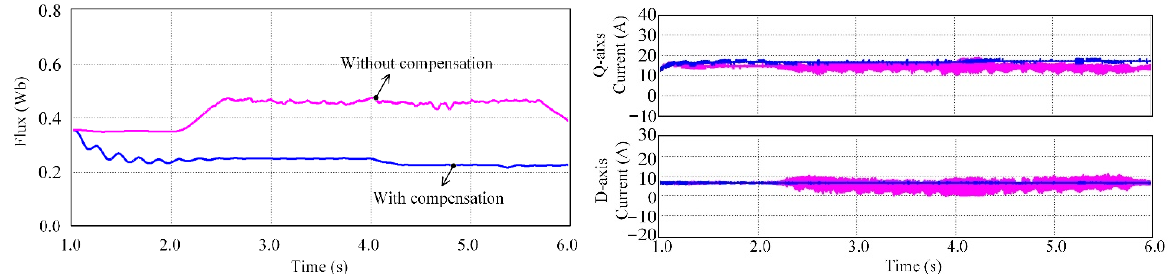
Figure 10. Rotor flux, d-axis, and q-axis current comparative waveforms at 3000 rpm with a 15 Nm load.